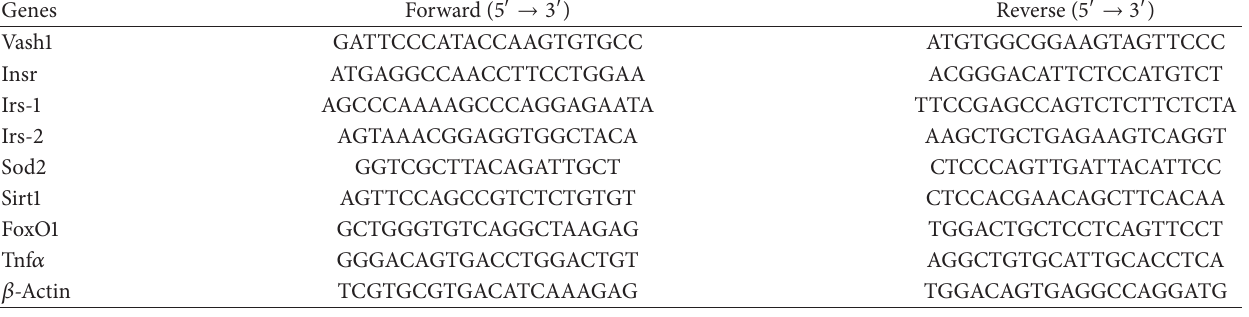
Table 2: Primer list.